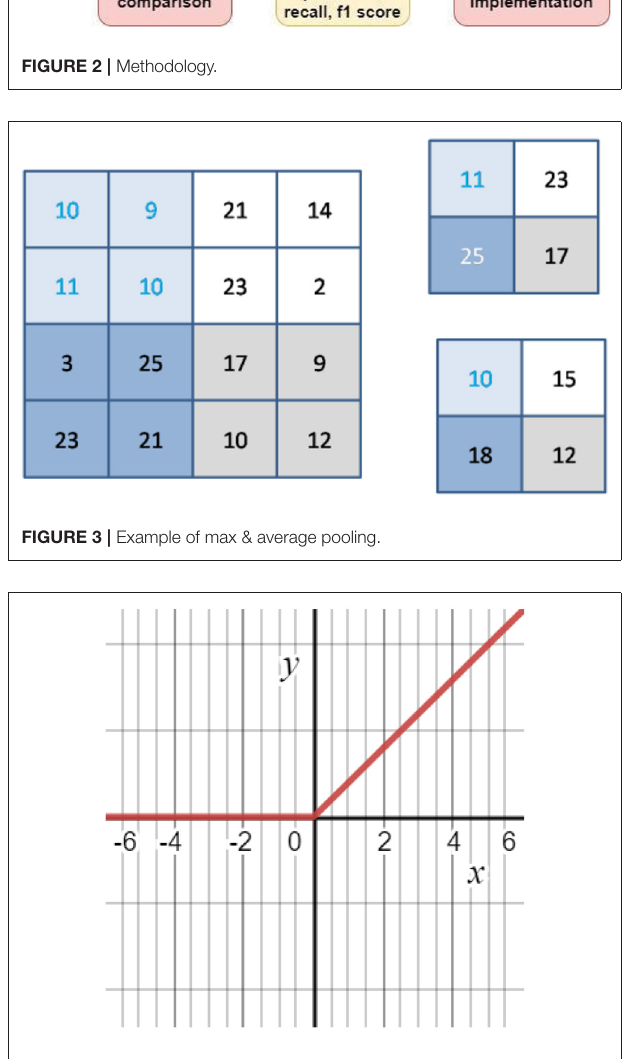
FIGURE 4 | ReLu activation